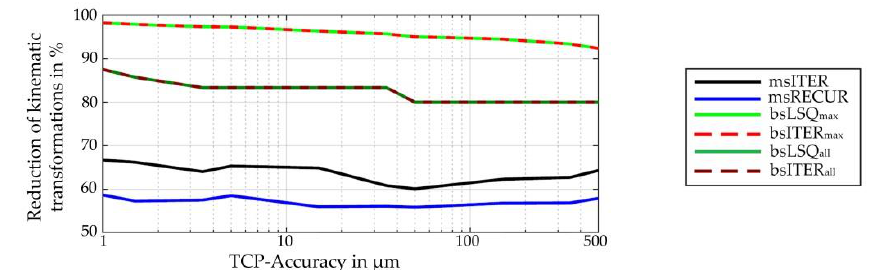
Figure 14. Reduction of the number of kinematic transformations by using the approach.